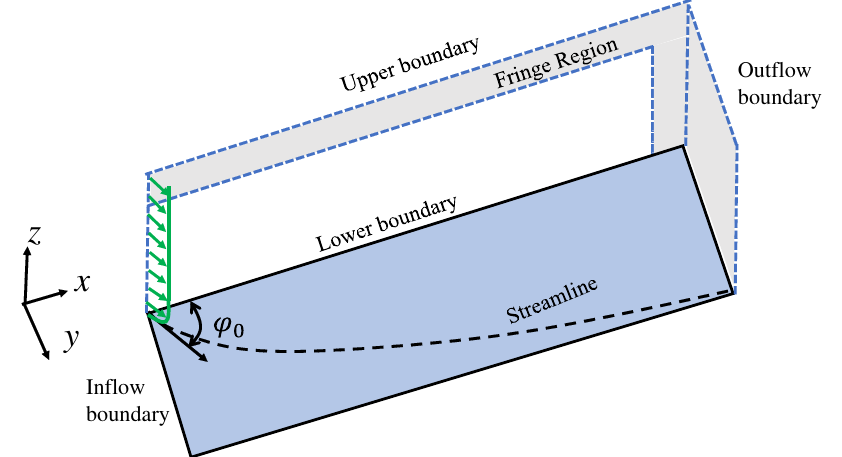
Figure 1. Schematic of swept flat-plate boundary